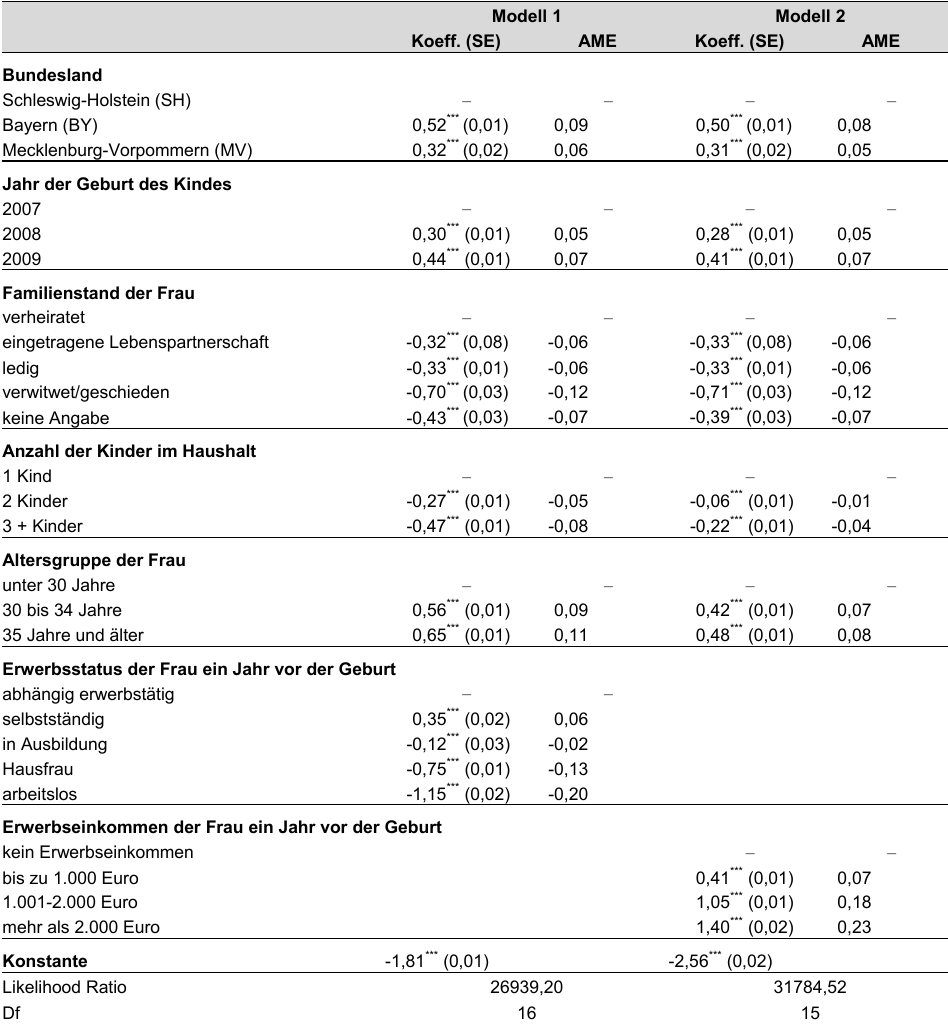
Tabelle 1 : Determinanten eines Partnerantrags in BY, MV und